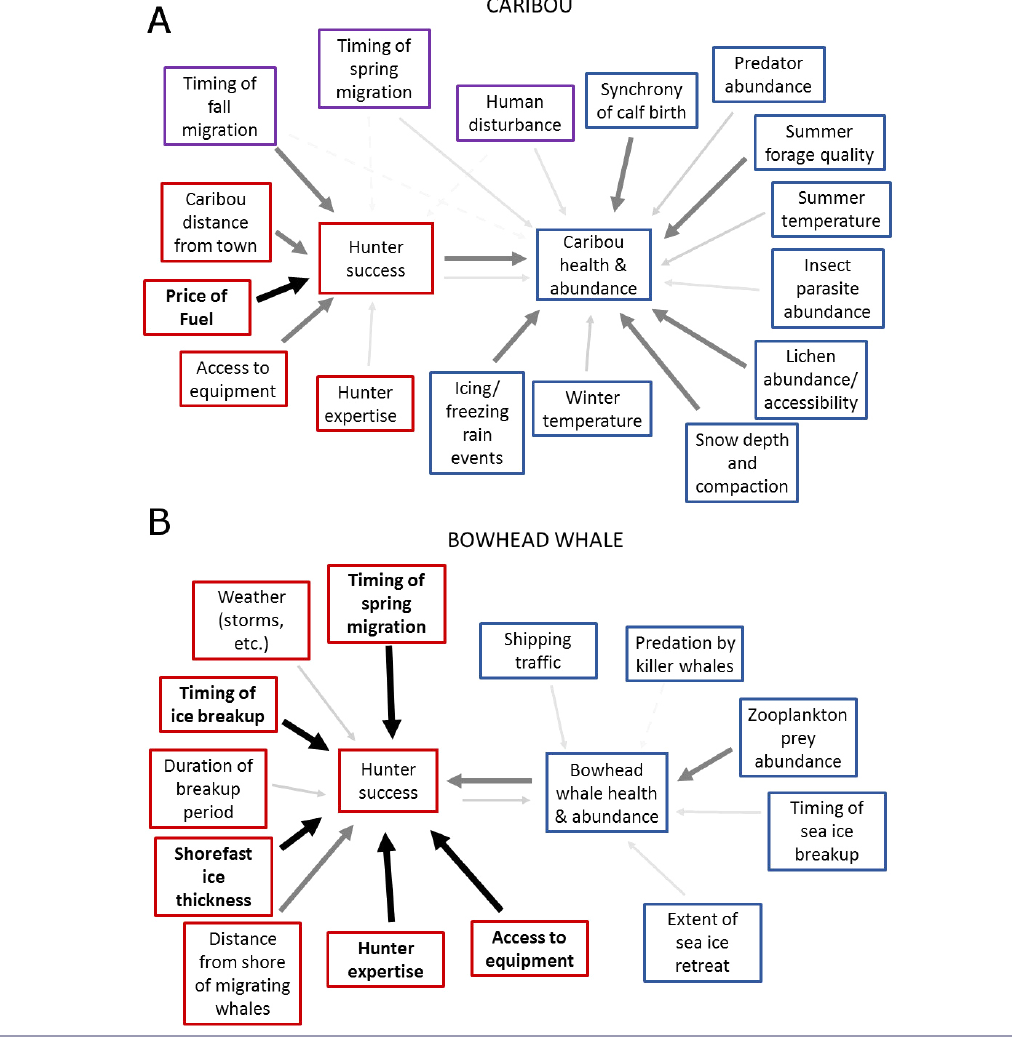
Fig. 3 . Factors influencing hunter success (outlined in red) and health and abundance (outlined in blue) of (A) caribou ( Rangifer tarandus ) and (B) bowhead whales ( Balaena mysticetus ) identified in workshops in Wainwright, Alaska. The darkness of arrows indicates the proportion of people who considered each factor as “very important.” Factors that were considered “very important” by > 80% of respondents are in bold. See Appendix 2 for a full table of results. Data were collected during workshops 3 and 4 by 8